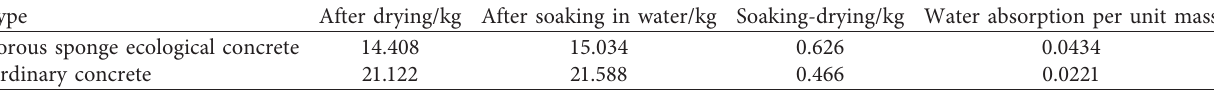
Figure 4: Compressive strength of concrete specimens with different mineral powder contents on the 7 th , 14 th , and 28 th day. Table 2: Water retention of